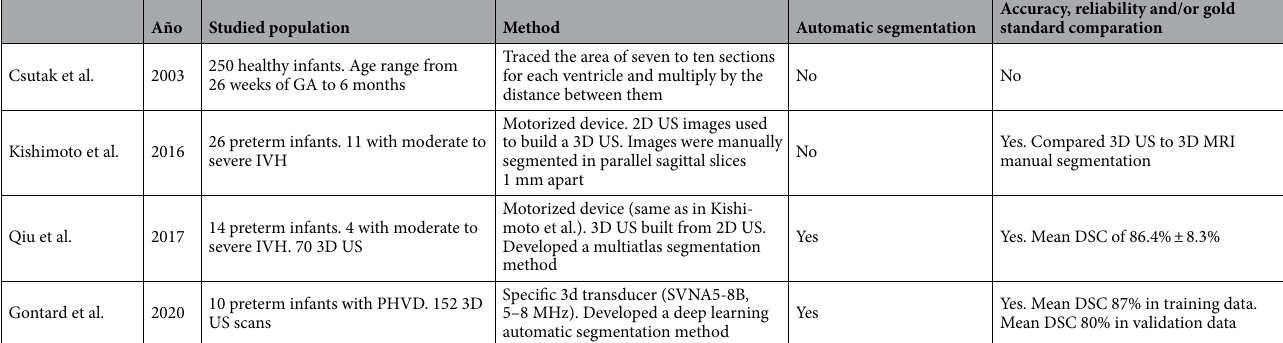
Table 3. Comparison of ventricular volume estimation bey ultrasonography. GA gestational age, MRI magnetic resonance imaging, DSC dice similarity coefficient, PHVD post haemorrhagic ventricular